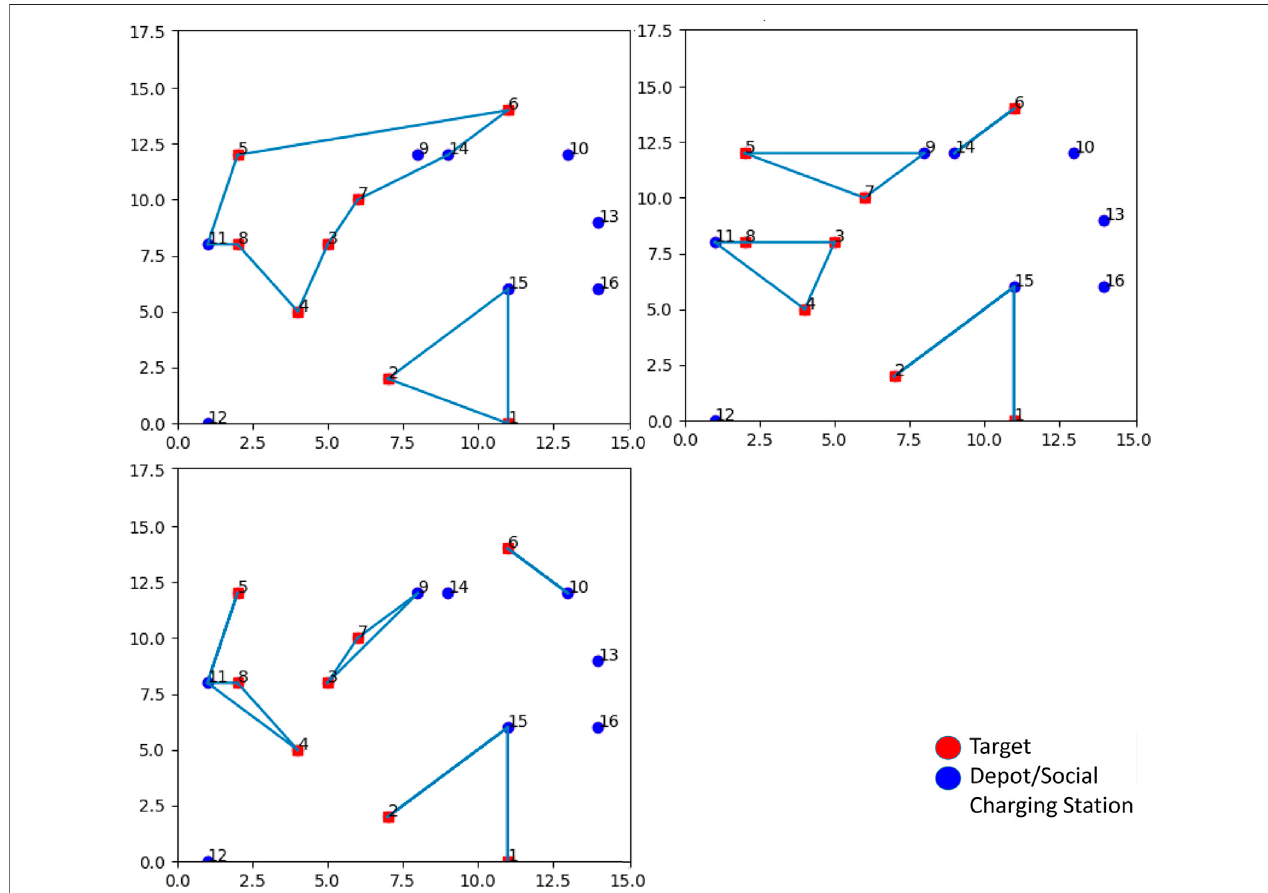
FIGURE 13 | Top left: inspection time spent in targets equal to 60 s (Path 1: 11, 8, 4, 3, 7, 14, 6, 5, 11; Path 2: 15, 2, 1, 15). Top right: inspection time spent in targetsequal to180 s(Path 1: 14,6, 14; Path2: 9,7, 5,nine; Path3: 11,8, 3,4, 11; Path4: 15,2, 15,1, 15). Bottom left: inspection time spent in targetsequal to300 s (Path 1: 10, 6, 10; Path 2: 9, 7, 3, 9; Path 3: 11, 5, 11, 8, 4, 11; Path 4: 15, 2, 15, 1, 15).